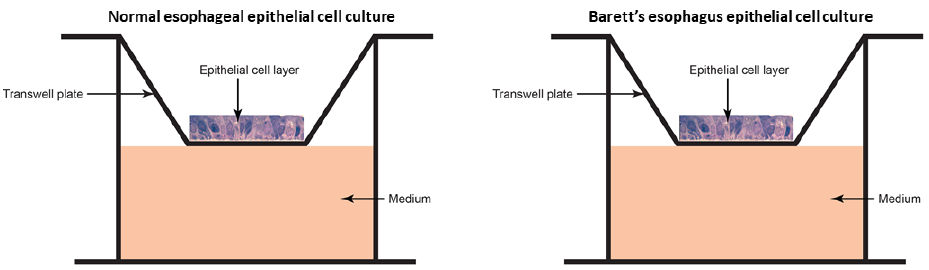
Figure 2. Ex vivo models for normal esophageal and Barrett’s esophagus epithelial